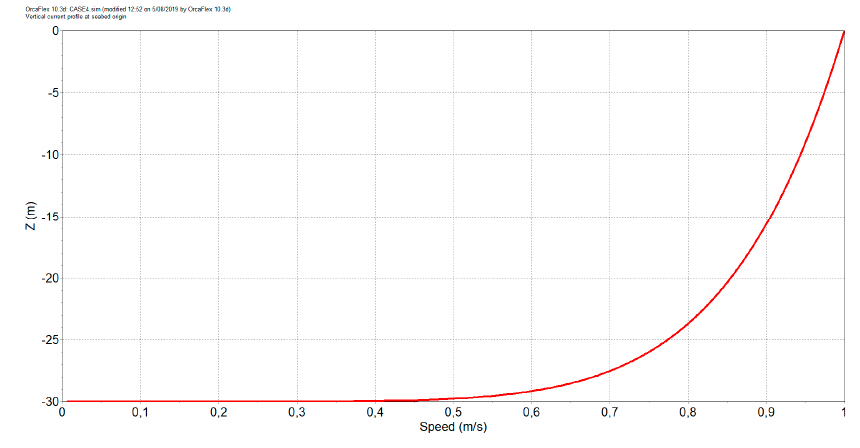
J. Mar. Sci. Eng. 2019 , 7 , x; doi: FOR PEER REVIEW Figure 14. Current speed profile along the depth. Figure 14. Current speed profile along the depth.